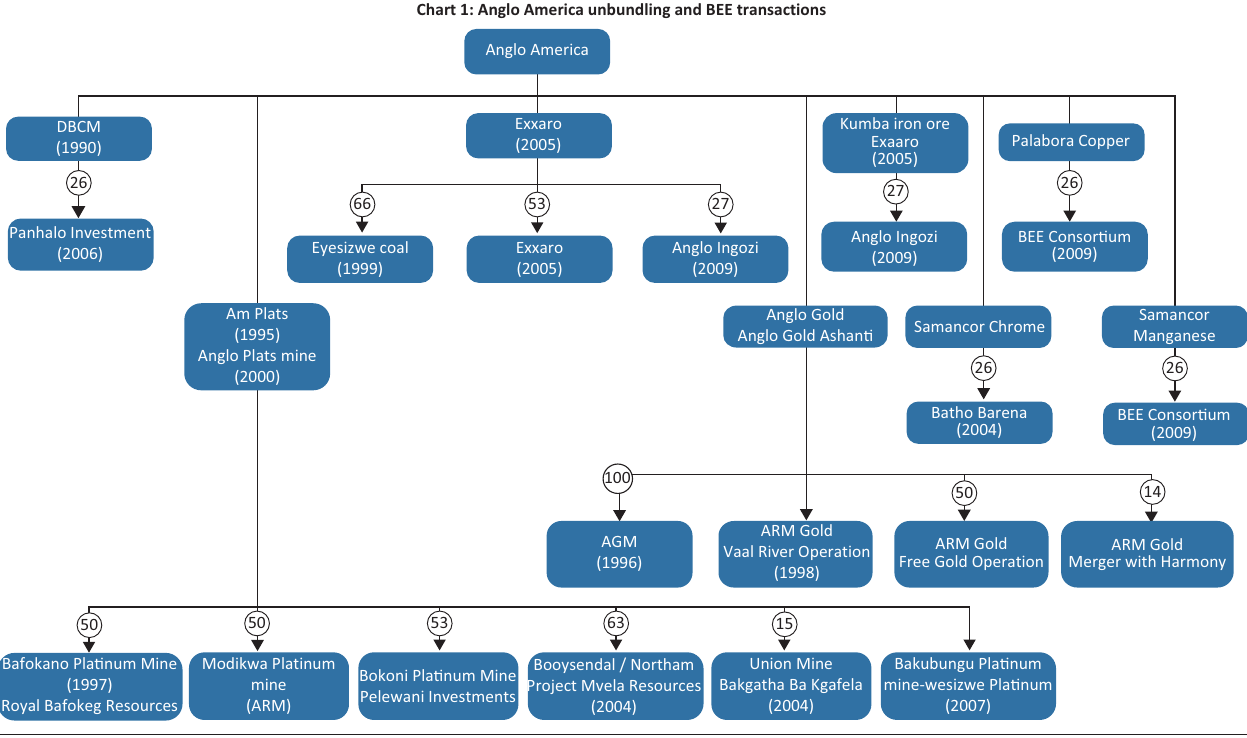
FIGURE 1: Anglo America unbundling and black economic empowerment